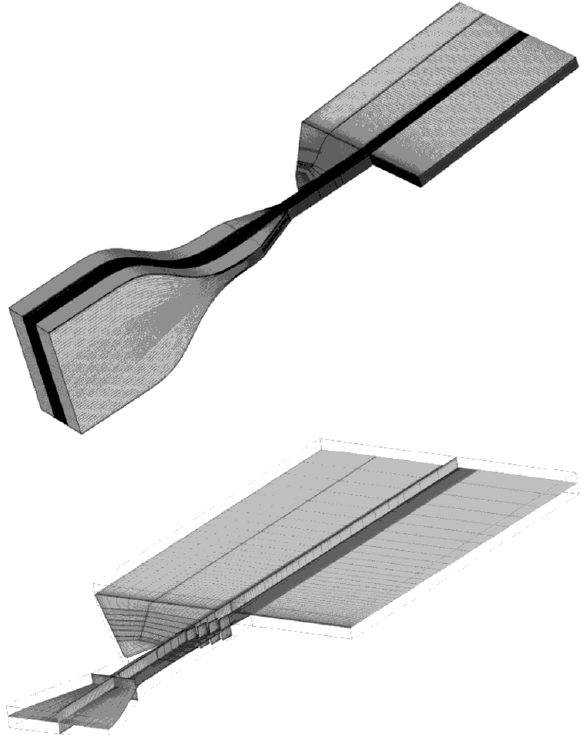
Figure 8. Computational mesh for steady-state sim- ulations (up) and unsteady simulations